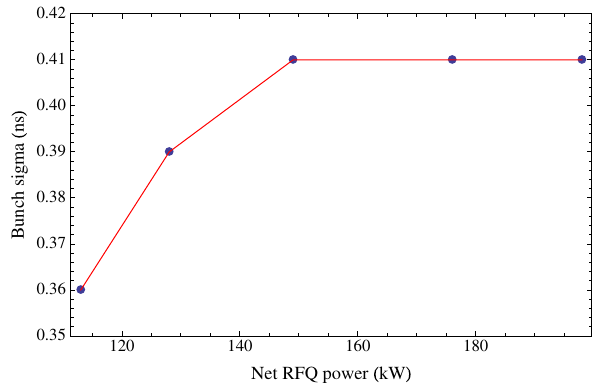
FIG. 30. This plot shows that the bunch length increases as power is increased until 150 kW where it reaches a stable length of 0.41 ns (sigma).